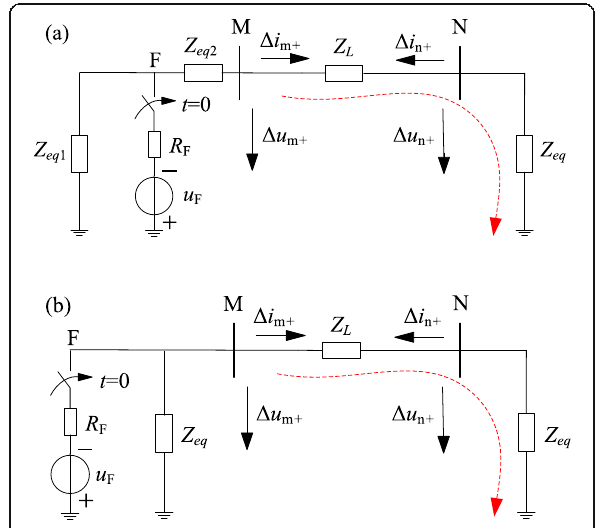
Fig. 4 Fault superimposed circuit for a fault occurring on the rectifier side. a Fault occurring on the converter valve or DC bus. b Fault occurring on the AC